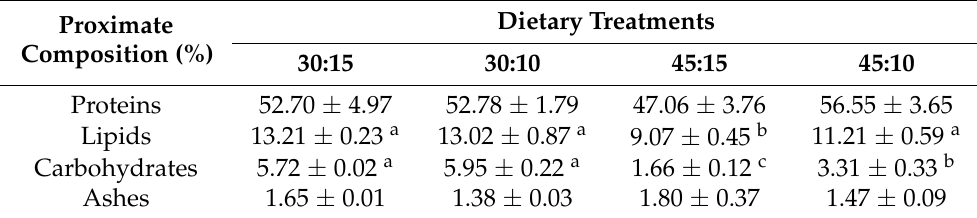
Table 4. Proximate composition (in % of dry matter) of P. punctifer individuals (26 dpf) fed the different diets. Data are expressed as mean ± S.D. ( n = 3). Different superscript letters denote the presence of differences statistically significant between dietary treatments (one-way ANOVA, p < 0.05). Dietary treatment codes correspond to the protein:lipid level included in the experimental